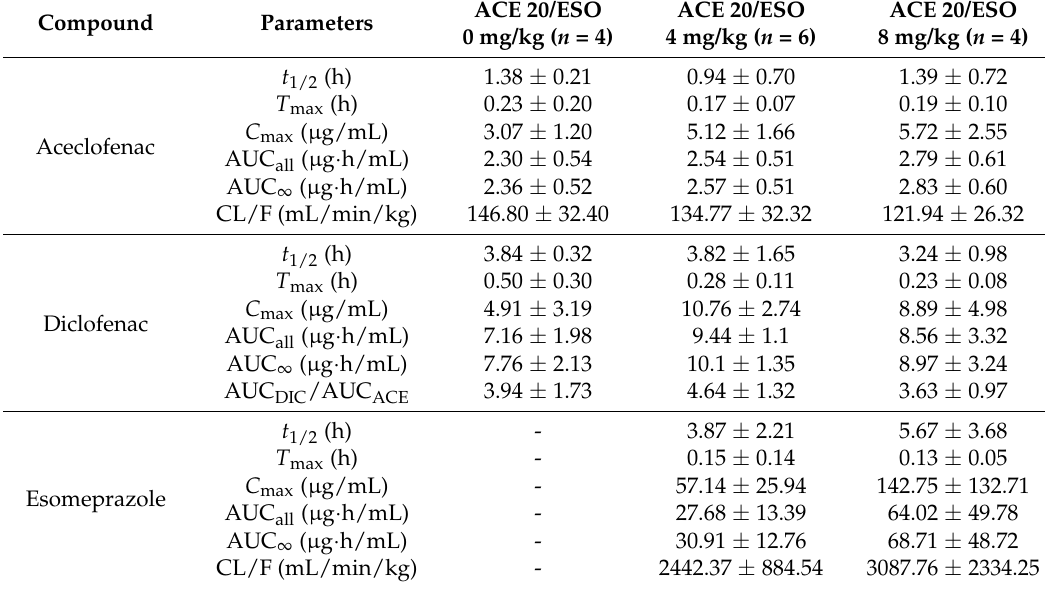
Table 1. Non-compartmental pharmacokinetic parameters of aceclofenac, diclofenac, and esomeprazole obtained after oral administration of aceclofenac (20 mg/kg) and esomeprazole (0, 4 and 8 mg/kg) to rats. Parameters include terminal half-life ( t 1/2 ), peak plasma concentration ( C max ), time to reach C max ( T max ), areas under the plasma concentration vs. time curve from time zero to the last observation time (AUC all ) and from time zero to infinity (AUC ∞ ), and systemic clearance (CL/F). Compound